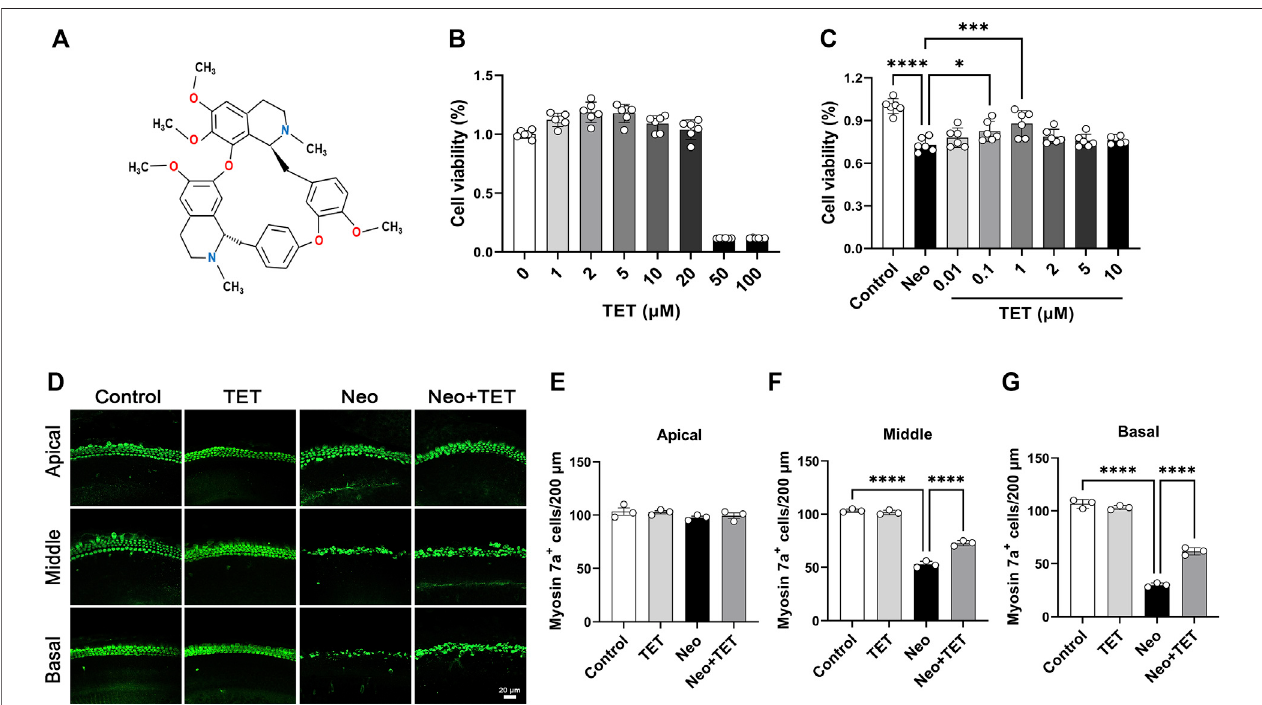
FIGURE 1 | TET increases HEI-OC1 cell viability and promotes cochlear hair cell survival after neomycin exposure (A) Structure of TET (B) The toxicity of TET at different doses (1, 2, 5, 10, 20, 50, 100 μ M) in HEI-OC1 cells wasmeasured by CCK-8 (n = 6) (C) CCK-8results showing the protective effectsof TET on HEI-OC1 cells after neomycin treatment (n = 6) (D) Immunostaining of hair cells with anti-Myosin 7a antibody in the apical, middle and basal turns of the cochlea. Scale bars: 20 μ m (E-G) Quanti fi cation of the number of cochlear hair cells per 200 μ m in the apical, middle and basal turns (n = 3). * p < 0.05, *** p < 0.001, **** p <